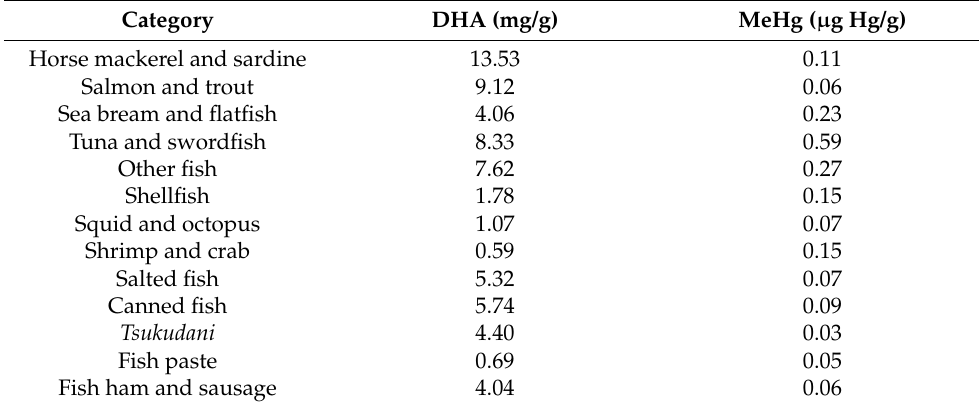
Table 1. Average contents of DHA and MeHg of 13 categories of